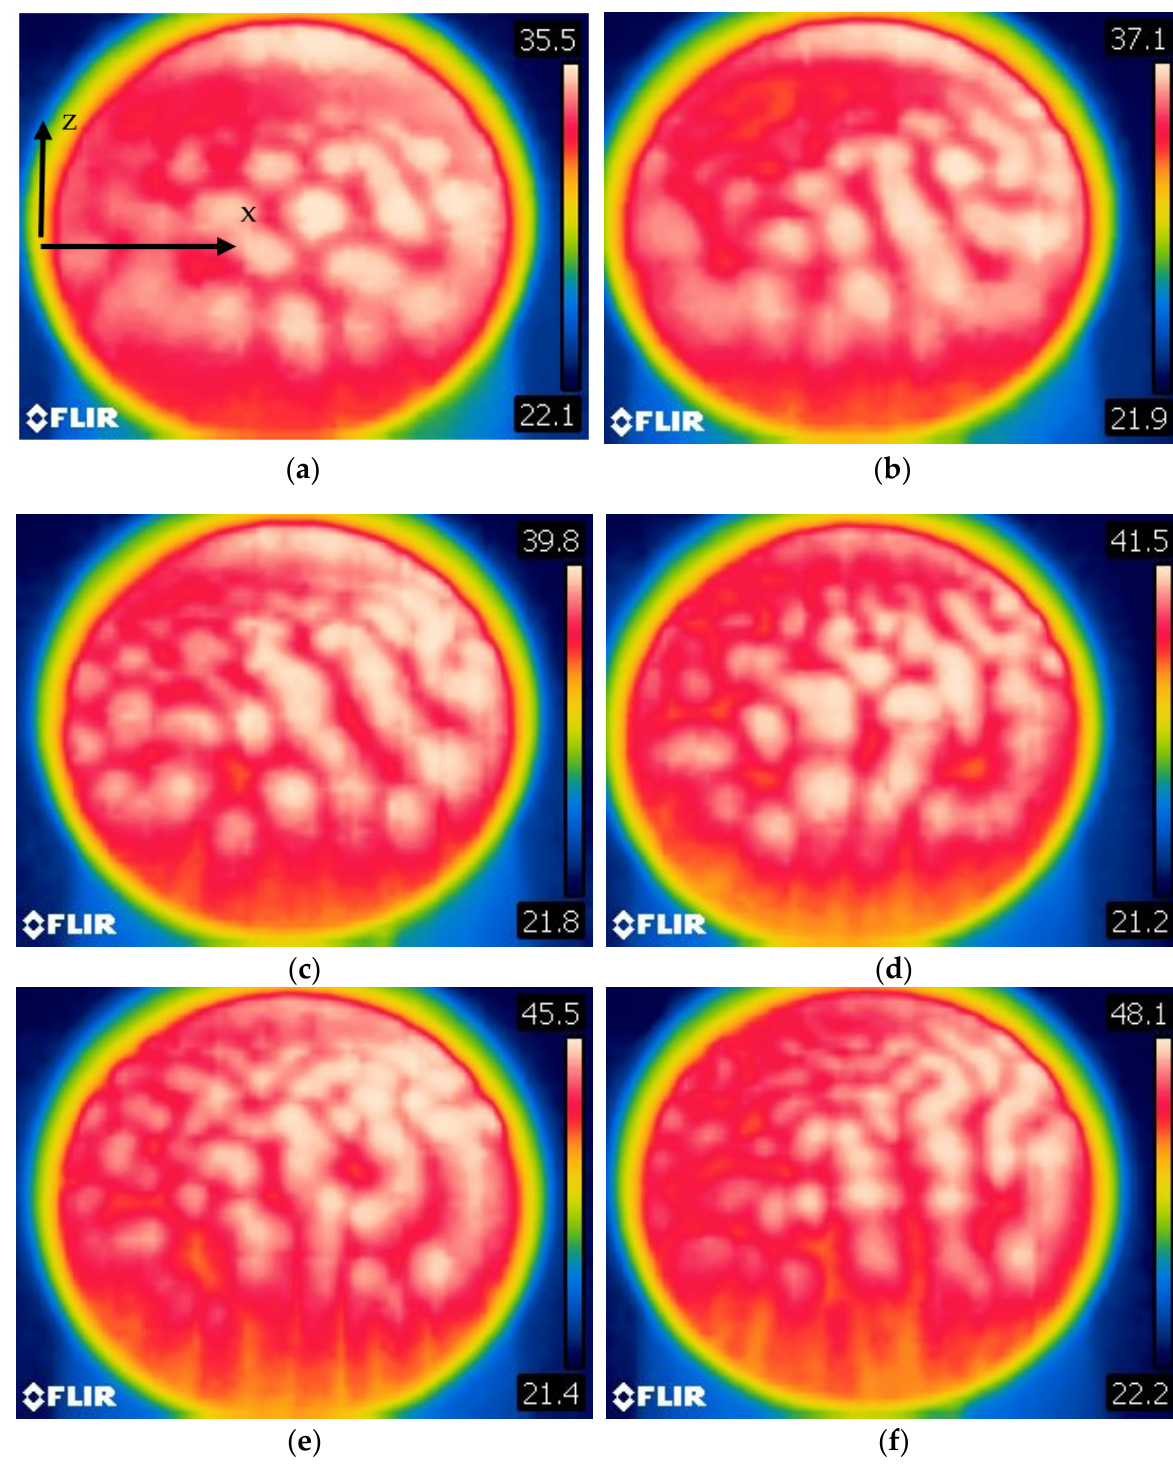
Figure 18. Surface temperature distribution for d = 0.75 cm ( Ω = 104 mL) and ϑ ≅ 5° ( A = 17.7, Bo dyn ≅ 1.94, Ra ≅ 8.6 × 10 2 × ∆ T , Ma ≅ 4.4 × 10 2 × ∆ T ) ( a ) ∆ T = 15 °C, ( b ) ∆ T = 18 °C, ( c ) ∆ T = 21 °C, ( d ) ∆ T = 24 °C, ( e ) ∆ T = 27 °C, ( f ) ∆ T = 30 °C (the x and z axes correspond to the horizontal and vertical directions in all the panels).